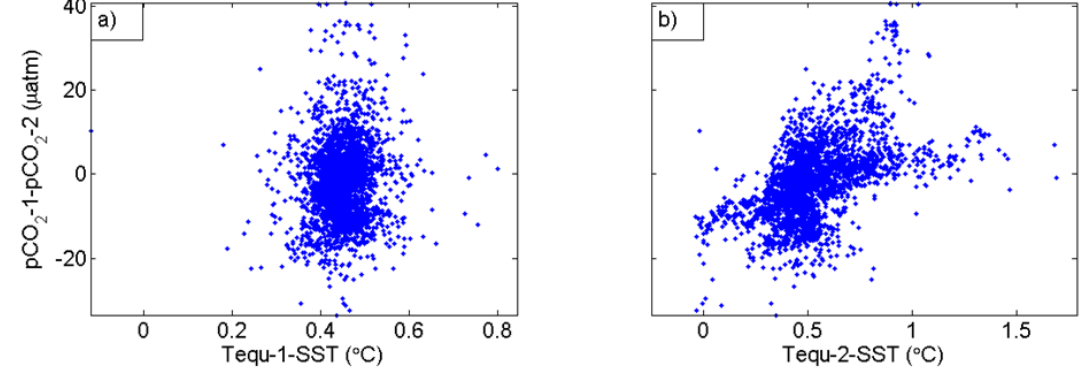
Figure 4. Difference between the two p CO 2 data sets and (a) the difference between the temperature inside equilibrator 1 and sea surface temperature, and (b) the difference between the temperature inside equilibrator 2 and sea surface